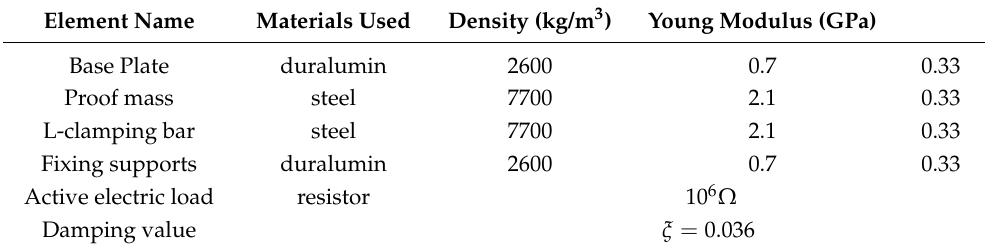
Table 2. Mechanical properties of materials.